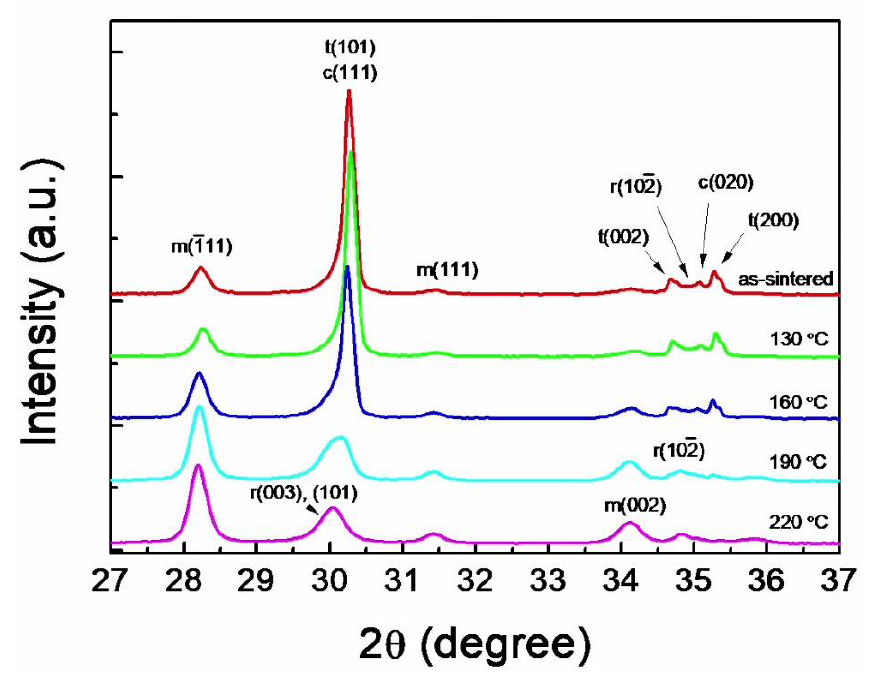
Figure 5. X-ray diffraction patterns of 3Y-TZP aged for 10 h at temperatures ranging from 130 to 220 °C after sintering at 1550 °C for 20 h. The pattern for the as-sintered specimen was added for comparison. The asymmetric broadening, associated with r-ZrO 2 and c-ZrO 2 , increases with aging temperature and corresponds to r-ZrO 2 at 220 °C suggesting that aging results in both t → m and c → r phase transformations.